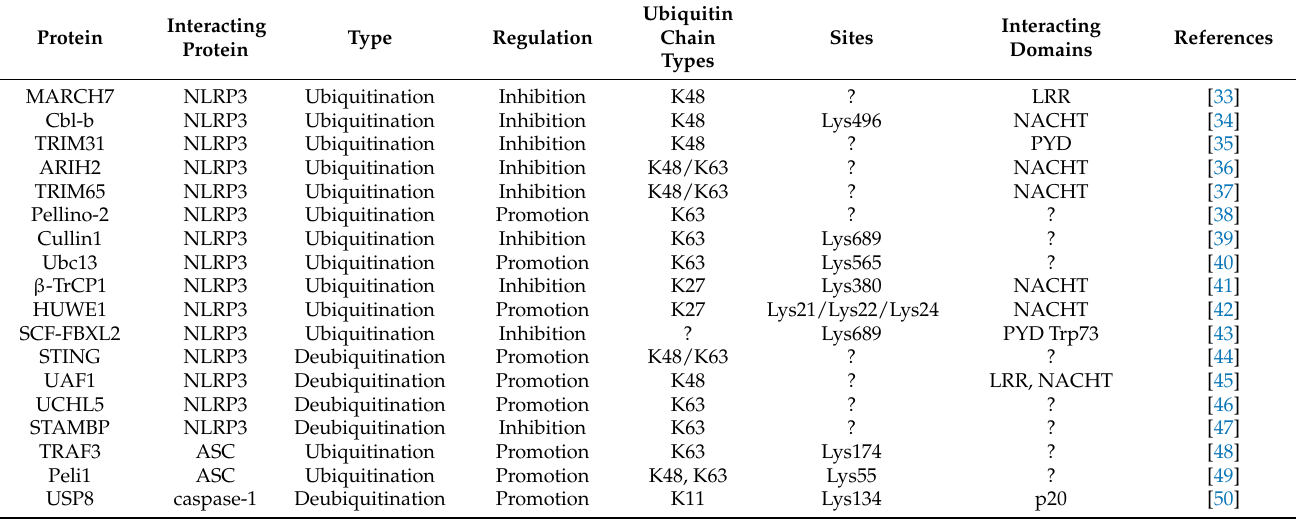
Table 1. Ubiquitination and deubiquitination of NLRP3 inflammasome